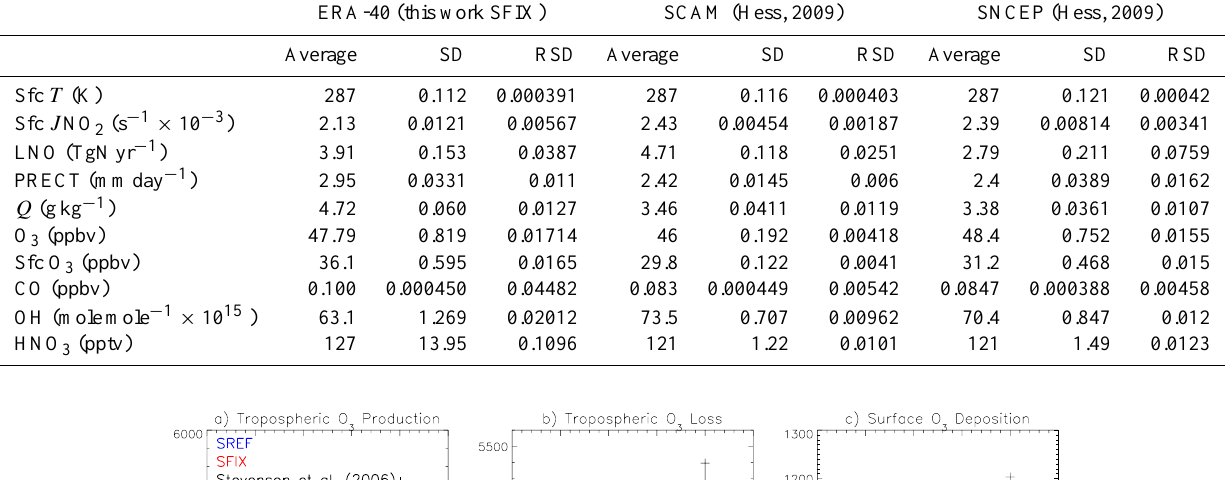
Table 3. Average, standard deviation (SD) and relative standard deviation (RSD, standard deviation divided by the mean) of globally averaged variables in this work, SCAM and SNCEP(Hess and Mahowald, 2009) (1980–2000). Three dimensional variables are density weighted and averaged between the surface and 280hPa. Three dimensional quantities evaluated at the surface are prefixed with Sfc. The standard deviation is calculated as the standard deviation of the monthly anomalies (the monthly value minus the mean of all years for that month).